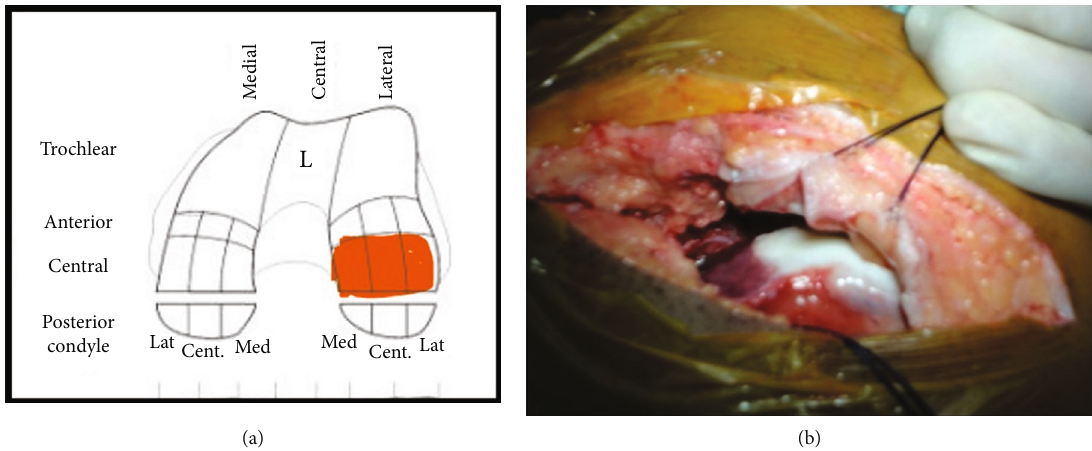
Figure 3: Cartilage mapping showing location of defect: (a) left lateral condyle femur involving central aspect and (b) intraoperative image of defect (ICRS grade